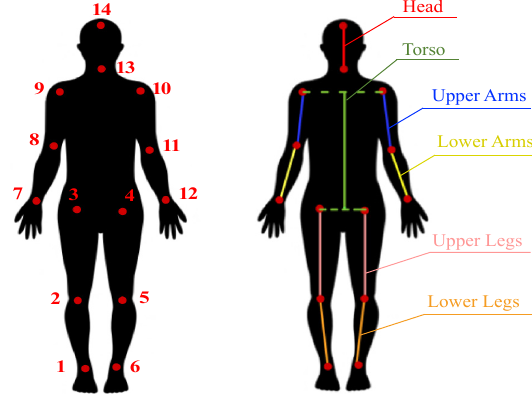
Figure 3. Major joints and body parts of human.